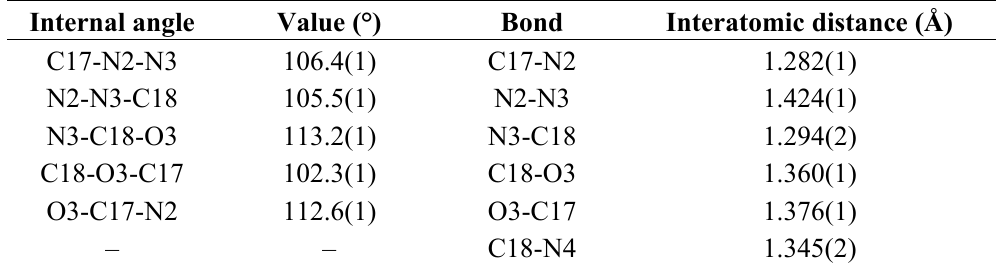
Table 2. Bond angles and lengths for the 2-amino-1,3,4-oxadiazole moiety of 2 . Internal